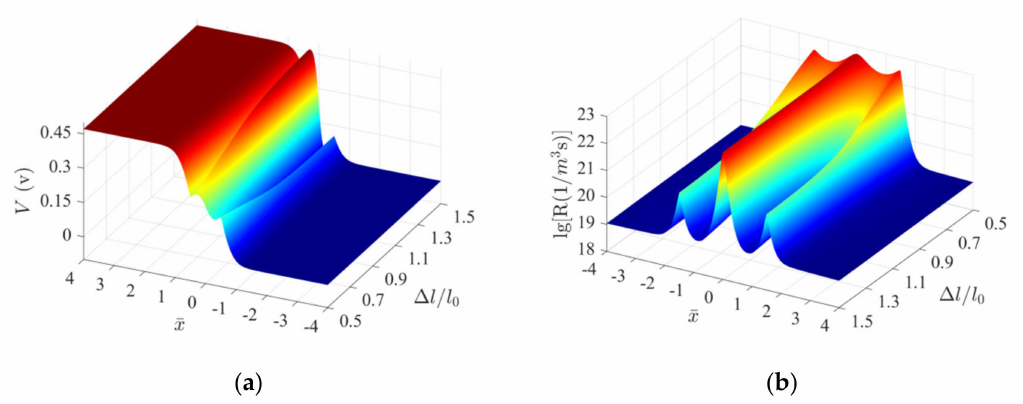
Figure 4. Evolution characteristics of the important physical quantities characterizing a ZnO PN junction subjected to a tensile-mode MIAPB under conditions of L A / l 0 = 0. ( a ) Electric potential configurations and ( b ) recombination